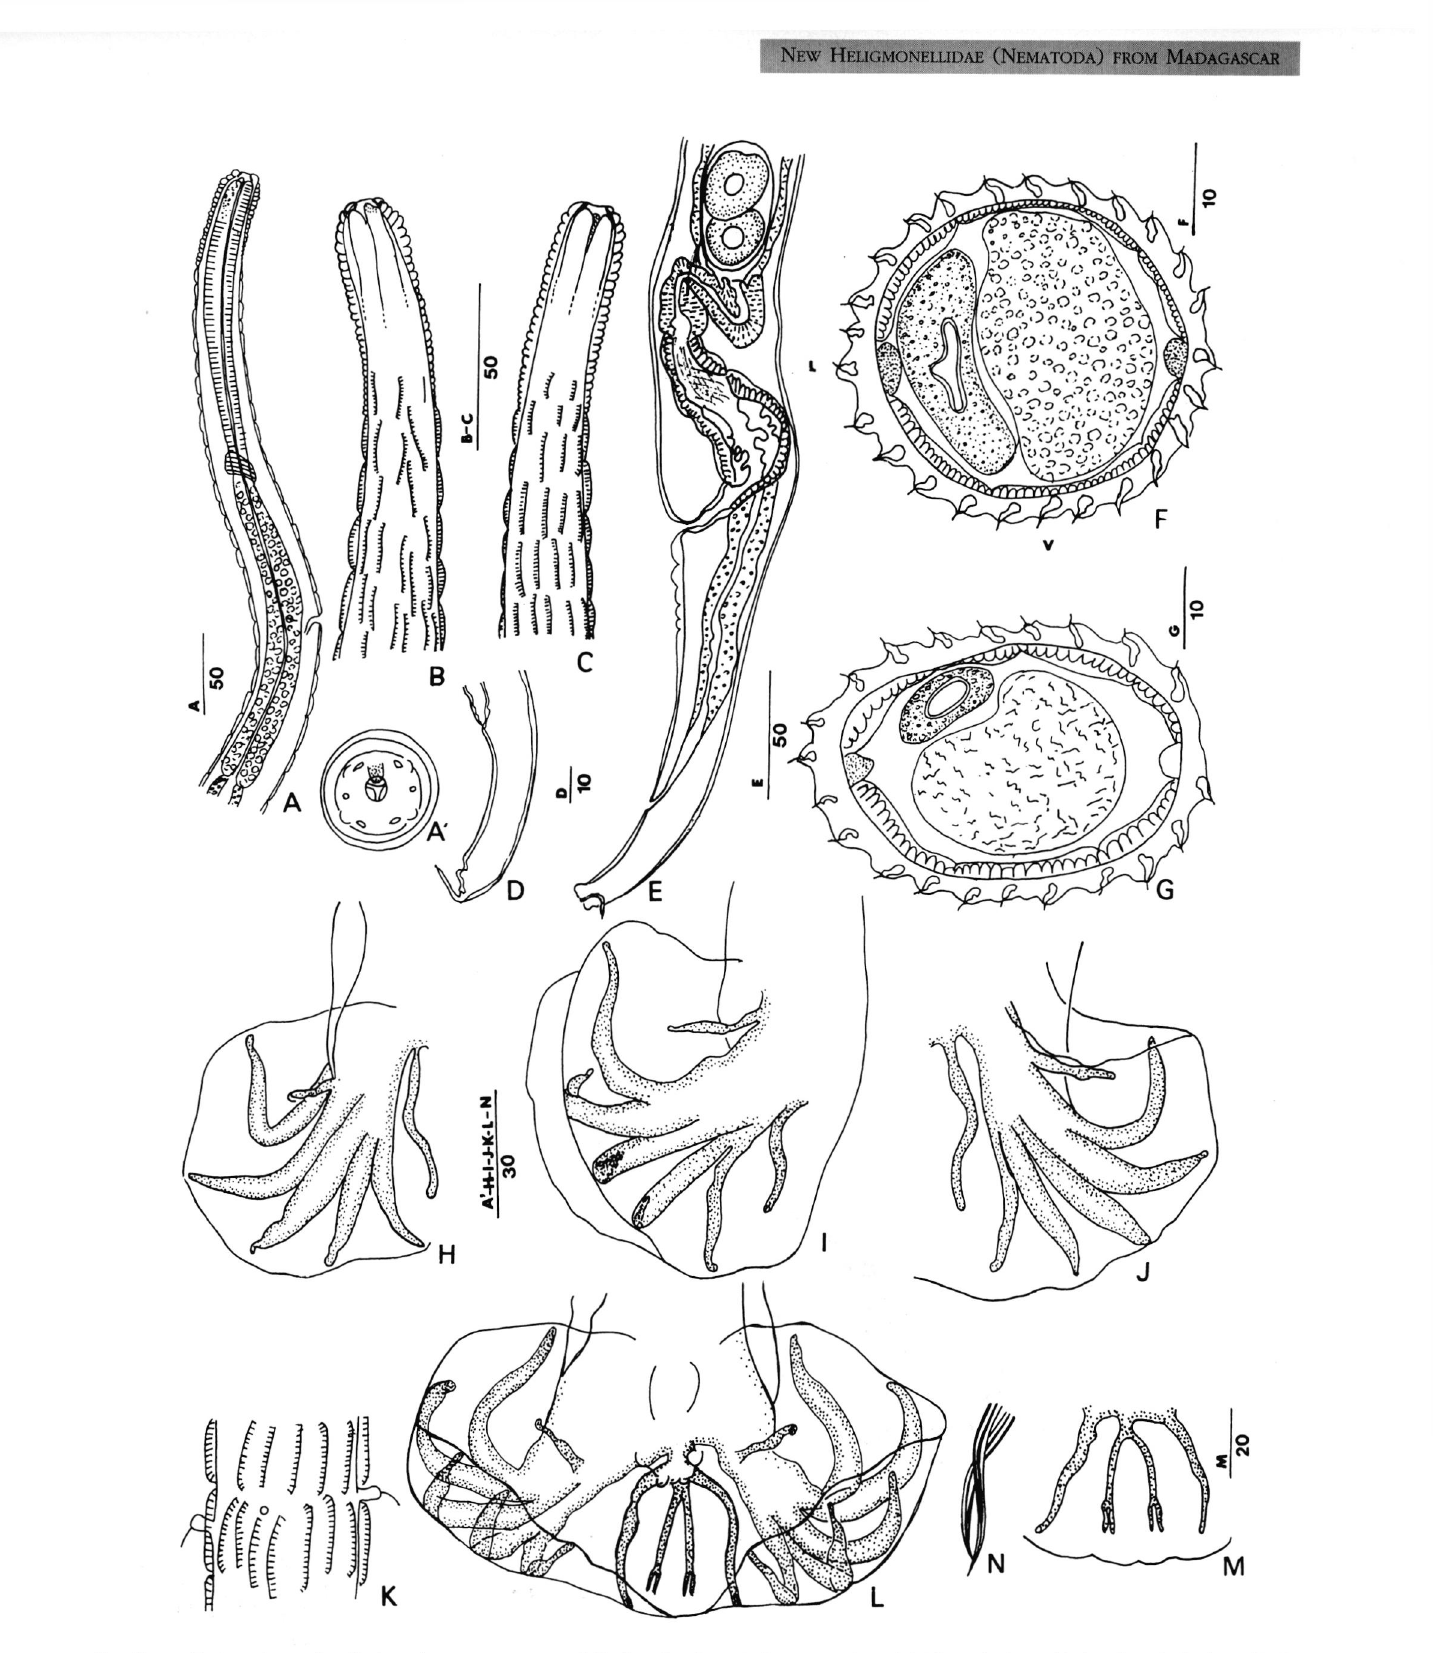
Fig. 2. — Nesomystrongylus fissicauda n. gen., n. sp. A-E, female, A, anterior extremity, right lateral view, A', head, apical view; B, C, beginning of cuticular ridges, respectively left lateral and ventral view, D, caudal extremity with spine, left lateral view, E, posterior extre­ mity, left lateral view; F-G, cuticular ridges, transverse sections at mid-body. F, female, G, male; H-J, caudal bursa of male, H, right lobe, ventral view, I, left lobe, latero dorsal view, J, left lobe, ventral view; K, female, detail of the deirids and the excretory pore, ventral view; L, male, caudal bursa, ventral view; M, male, detail of the dorsal ray and rays 8, dorsal view; N, male, tips of the spicules, ventral view. Transverse sections orientated as figure 2, F. Abbreviations: V, ventral side; L. left